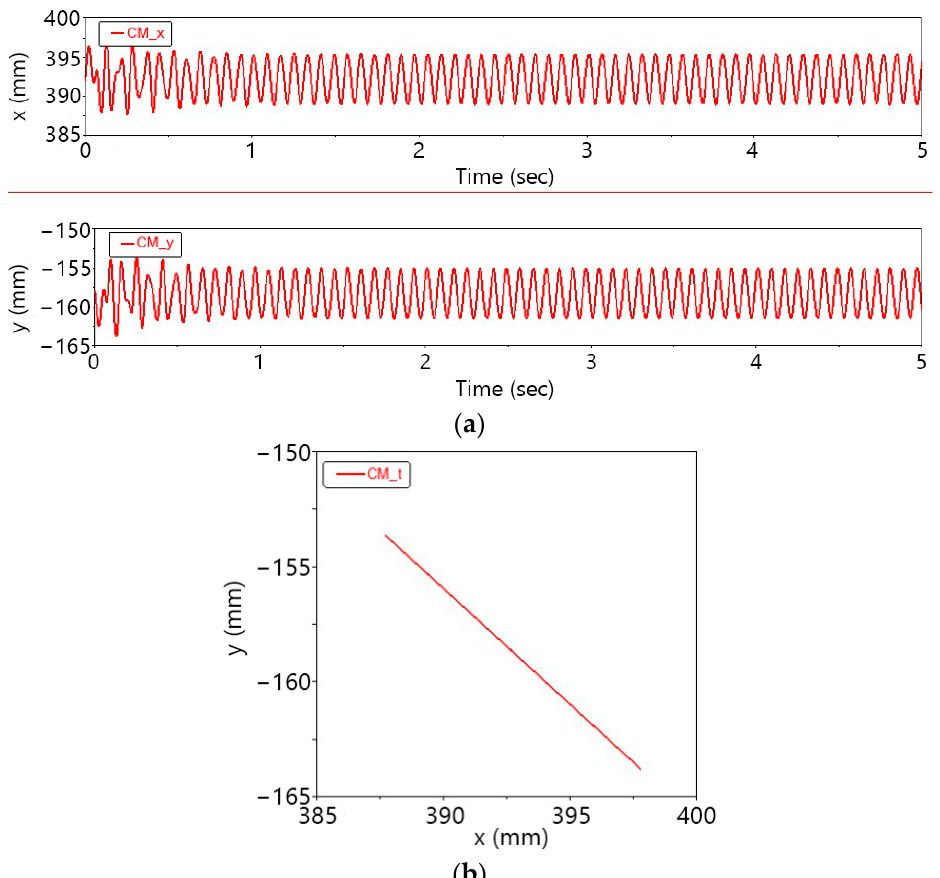
Figure 2. Motion curve of mass center of vibration exciter. ( a ) In x and y directions. ( b ) Centroid trajectory.